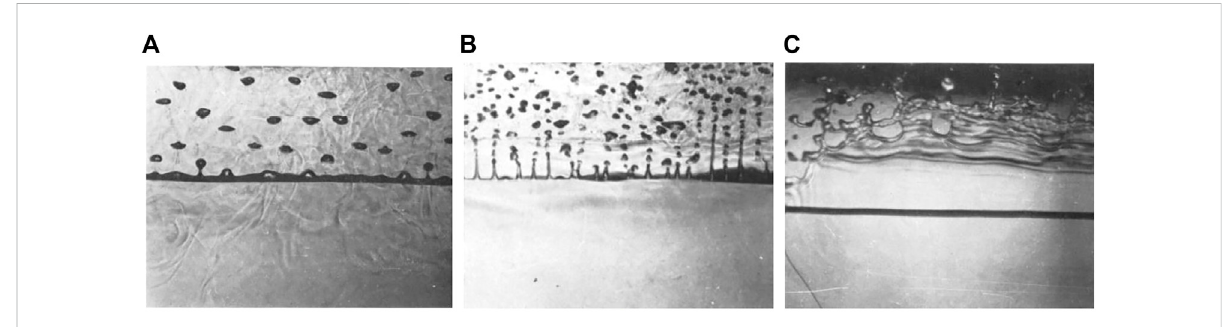
FIGURE 9 Film boiling experimental results for carbon dioxide at different cases. (A) 80 K overheat; (B) 110 K overheat; (C) 400 K overheat.